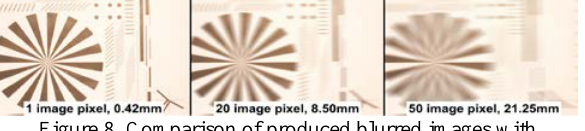
Figure 8. Comparison of produced blurred images with MATLAB filter.